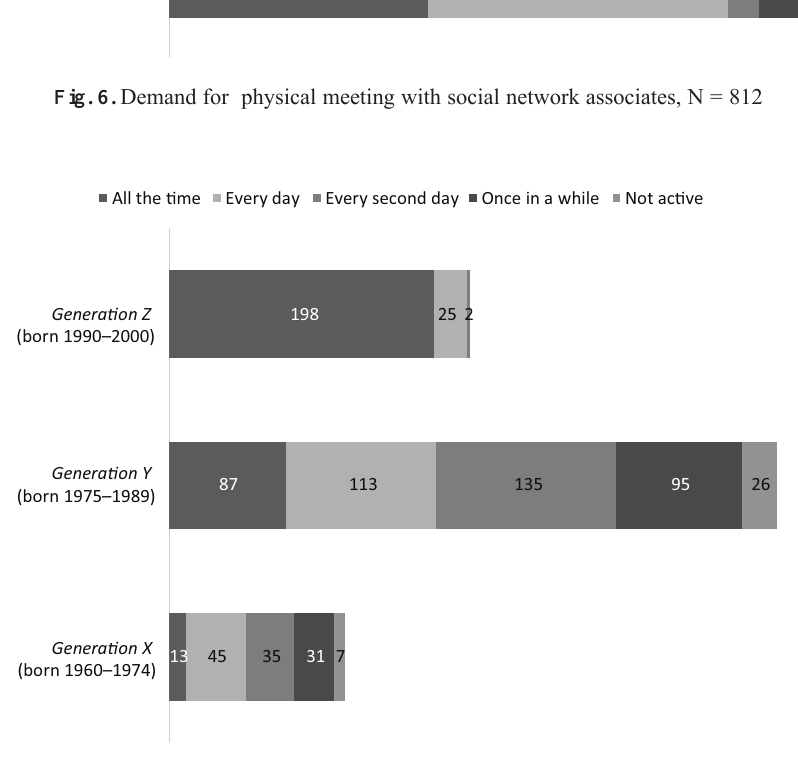
fig. 7. Frequency of social networking, N =